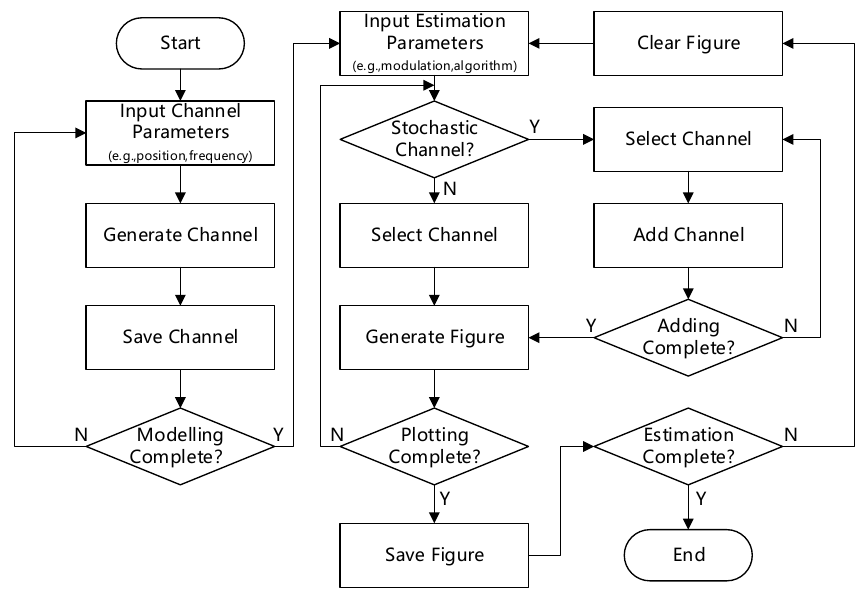
Figure 3. Flow chart of using simulation